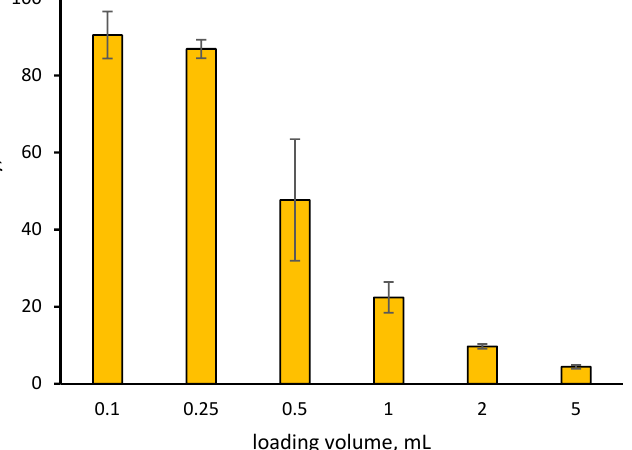
Figure 4. Effect of sample loading volumes on retention of ciprofloxacin, 200 ng mL − 1 in synthetic urine, diluted 9 + 1 v / v with 50 mmol L − 1 MES buffer, pH 4.5.